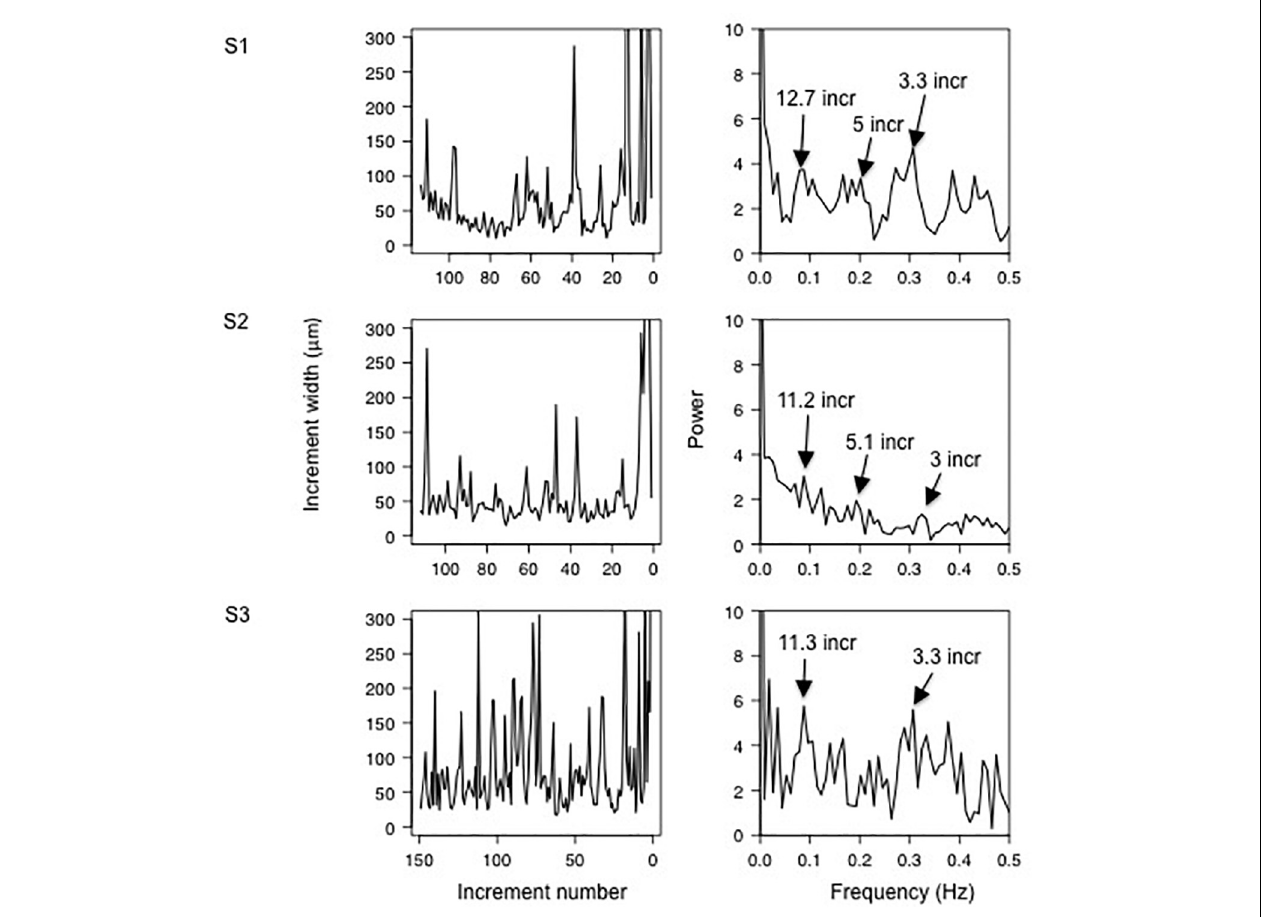
FIGURE 5 | (Left panel) increment number from the calcein mark (right side) to the collection (left side) for three representative Mytilus galloprovincialis shells S1 (FDS0118-3), S2 (FDD0118-4), and S3 (PF0118-3) between June 2017 and January 2018. (Right panel) Fast Fourier Transform showing the periodicities of the increment